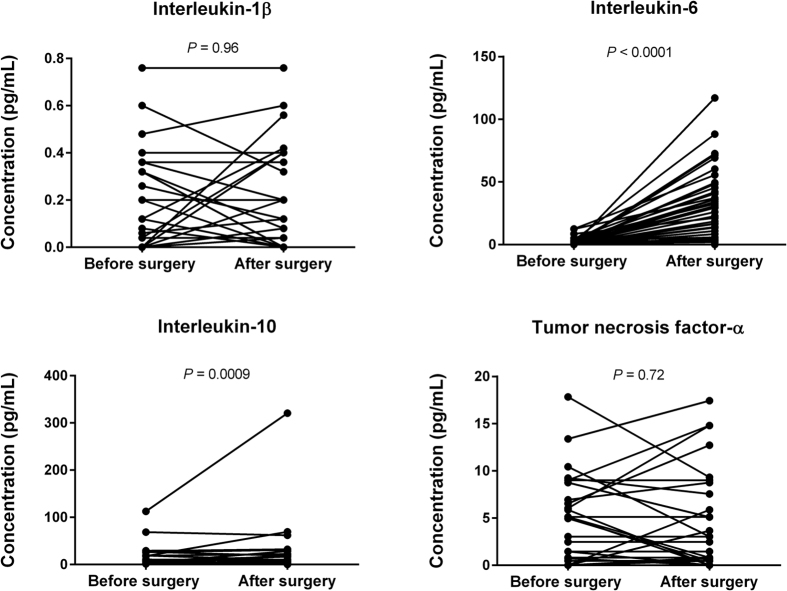
Levels of plasma cytokines in 43 non-infected control patients before surgery (baseline) and after surgery (2–6 h postoperatively).Comparisons were performed using the Wilcoxon signed-rank test.